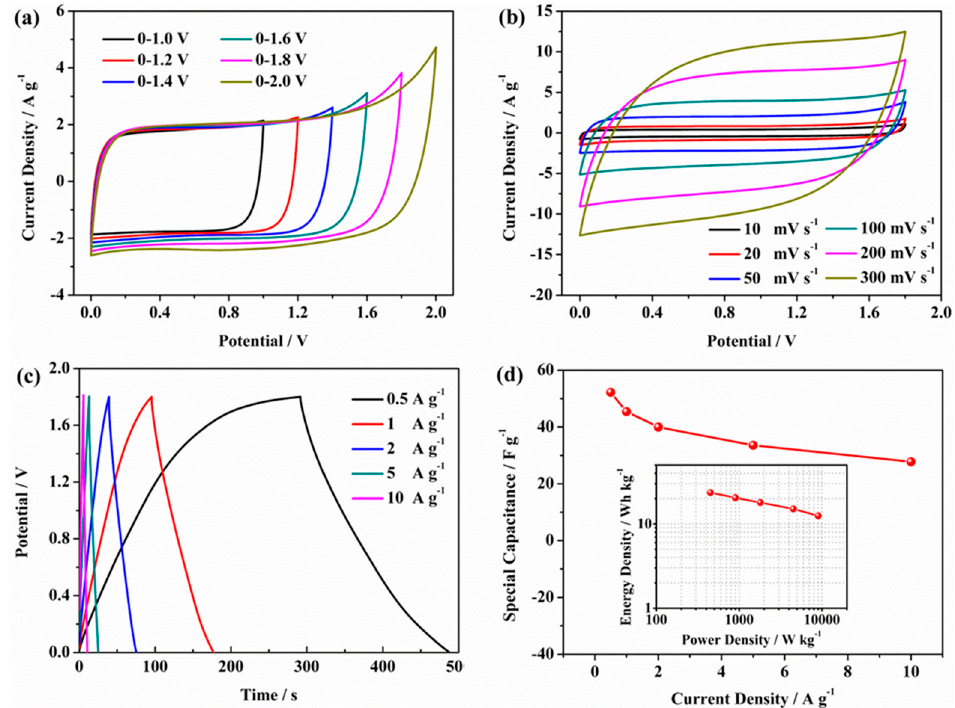
Figure 11. Electrochemical measurements of the as-assembled KAC-800 symmetric supercapacitor in 1 M Na 2 SO 4 electrolyte: ( a ) CV curves of the cell operated in different operation voltages at a scan rate of 50 mV s − 1 ; ( b ) CV curves of the cell at various scan rates. ( c ) GCD curves of the cell at various current densities; ( d ) capacitances of KAC-800 electrode at various current densities. The inset shows the Ragone plot.